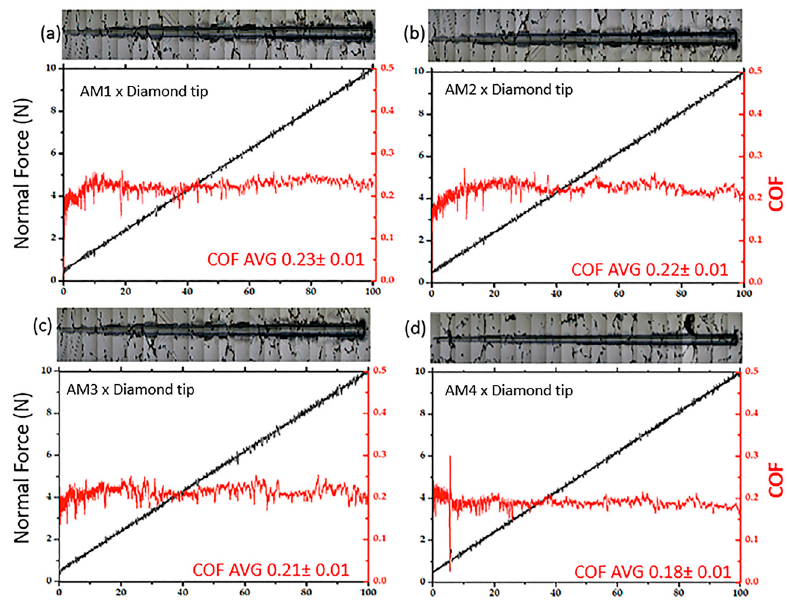
Figure 12. Experimental results for the ramp-load scratch testing of the Co-Cr-Mo alloy samples ( a ) AM1, ( b ) AM2, ( c ) AM3, and ( d ) AM4, using a Berkovich diamond indenter, showing the normal force (depth) and COF, together with images of the scratch tracks.